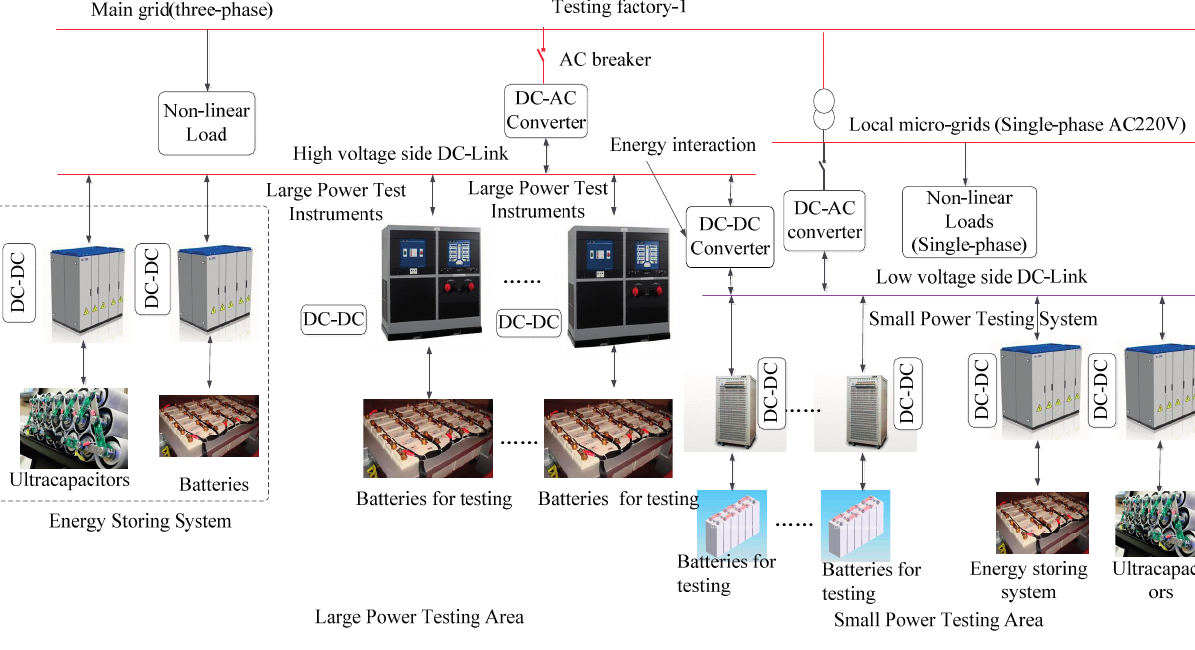
Figure 3. Architecture of the multiple converters with hierarchal DC-link voltage configuration in the